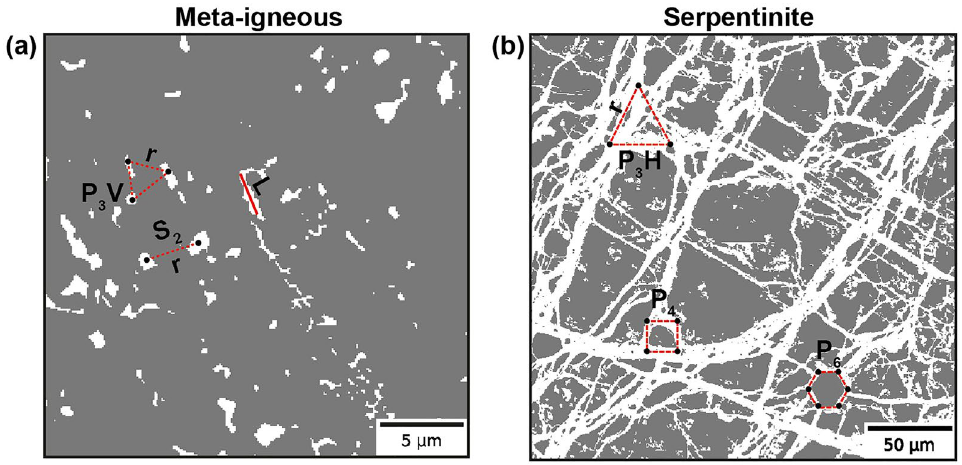
Figure 1. Illustration of polytope functions in meta-igneous rock ( a ) and serpentinite ( b ) samples. P 3 H , and P 3 V indicate the probability of vertices of horizontal and vertical triangles, and P 4 and P 6 are those of a square and hexagon, respectively. L is the lineal-path